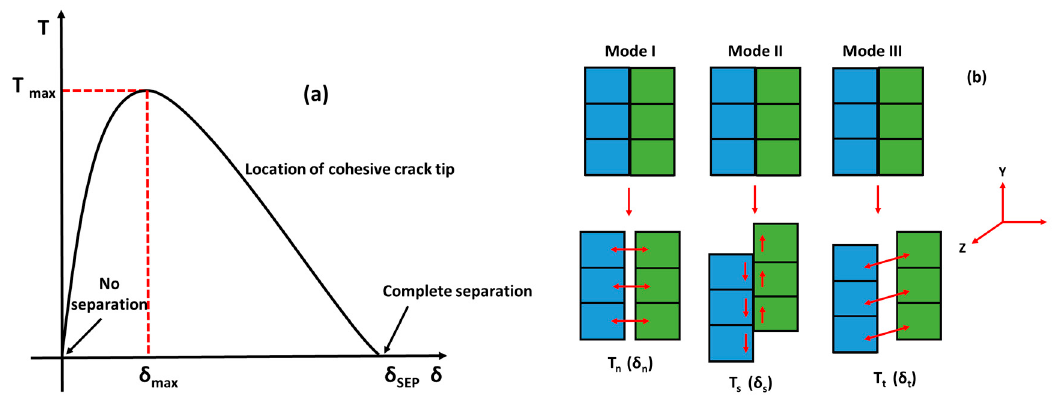
Figure 1. Cohesive zone damage; ( a ) typical traction separation behavior when a fiber is pulled out from the matrix [14], ( b ) traction separations for different fracture modes. Mode II fracture mode has been used in this analysis [15].